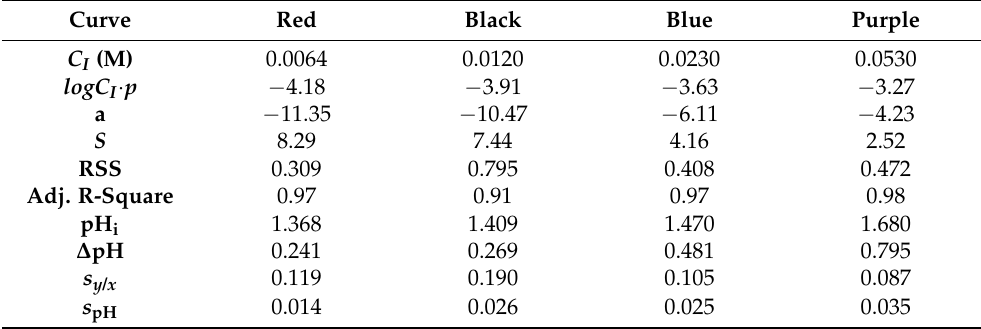
Table 2. Parameters a , S , RSS, Adj. R-Square, pH i , ∆ pH, s y / x , and s pH of the CSAs obtained at different C I values. The mean thickness ( p ) of each sensor is 101.0 ± 0.1 µ m.